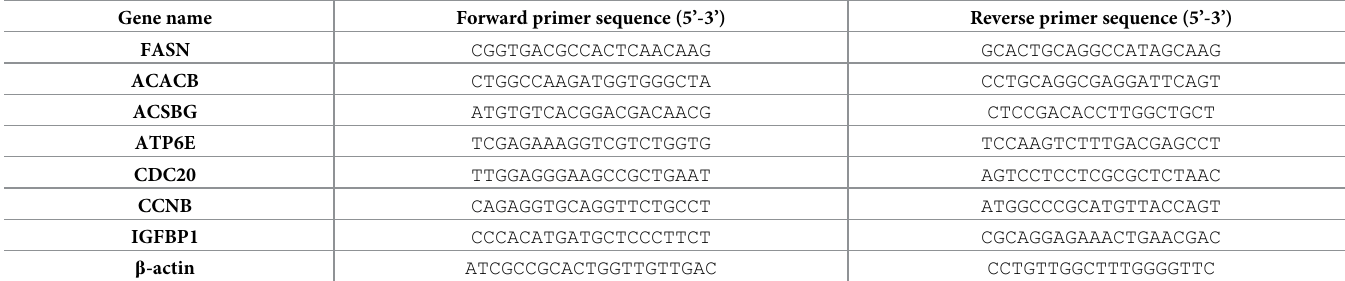
Table 1. Primer sequences used for real-time